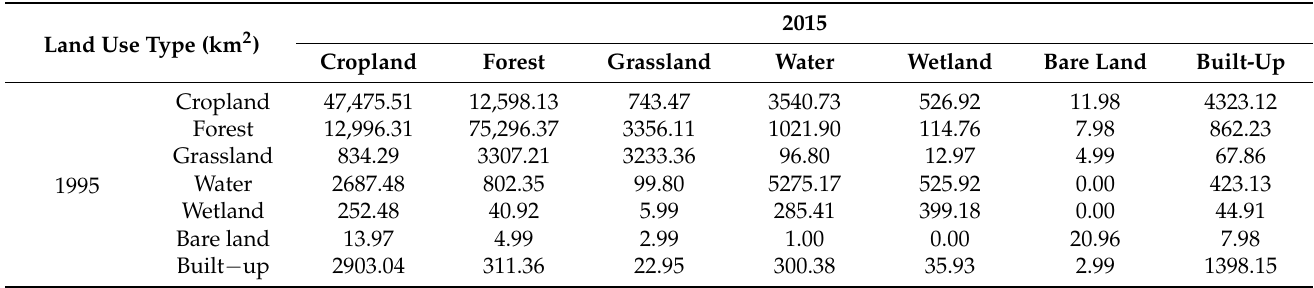
Table 3. Transition area matrix of LULC from 1995 to 2015 (km 2 ).